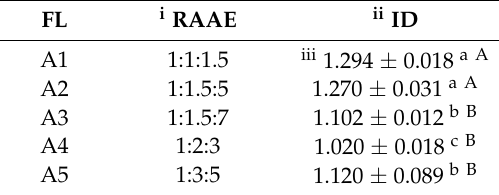
Table 3. IDs of FLs with different RAAEs.